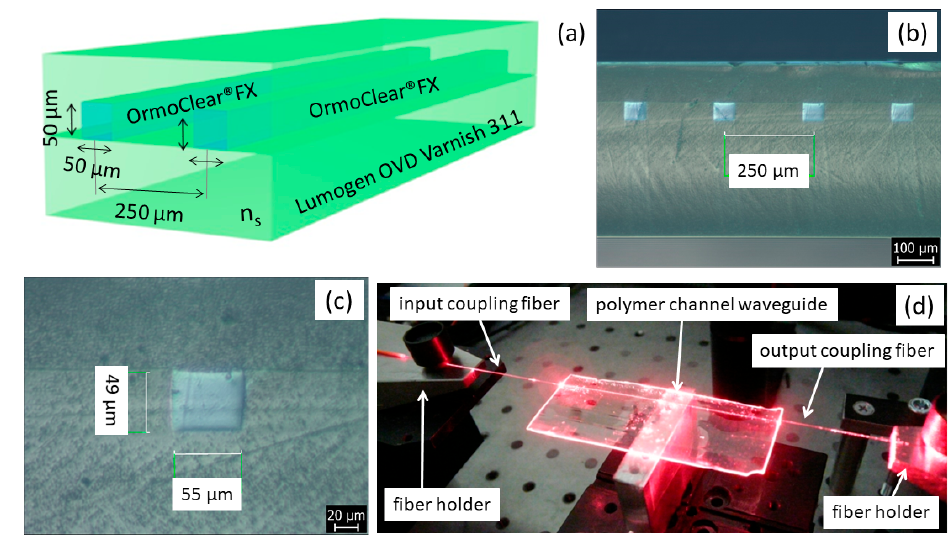
Figure 6. ( a ) Illustration of the optical channel waveguide, ( b ) the cross-sectional view of the four optical channel waveguides, ( c ) the detail view of the cross-section of a single optical channel waveguide, ( d ) photo of the measurement set-up with optical channel waveguide coupled with red light 650 nm.